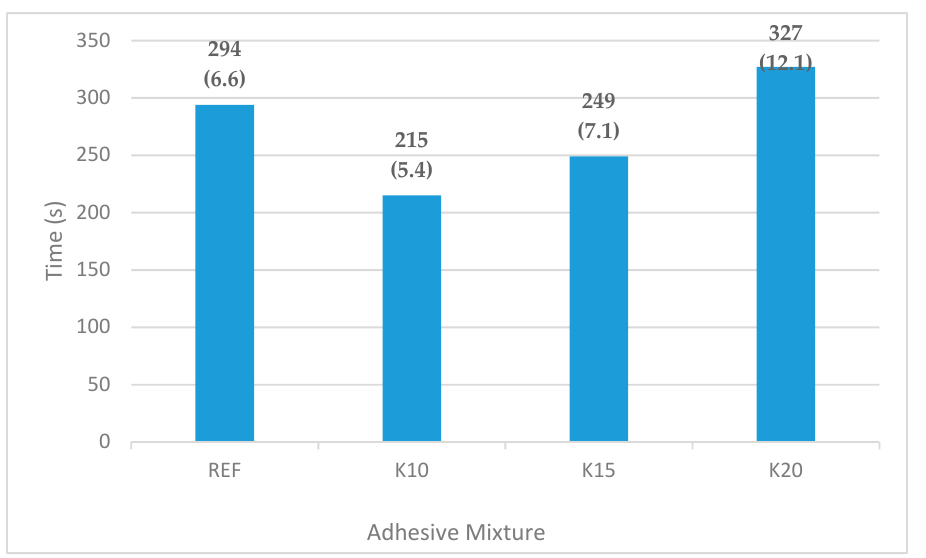
Figure 2. Time taken to heat to 105 °C in the centre of the adhesive layer (values in parenthesis are standard deviations).